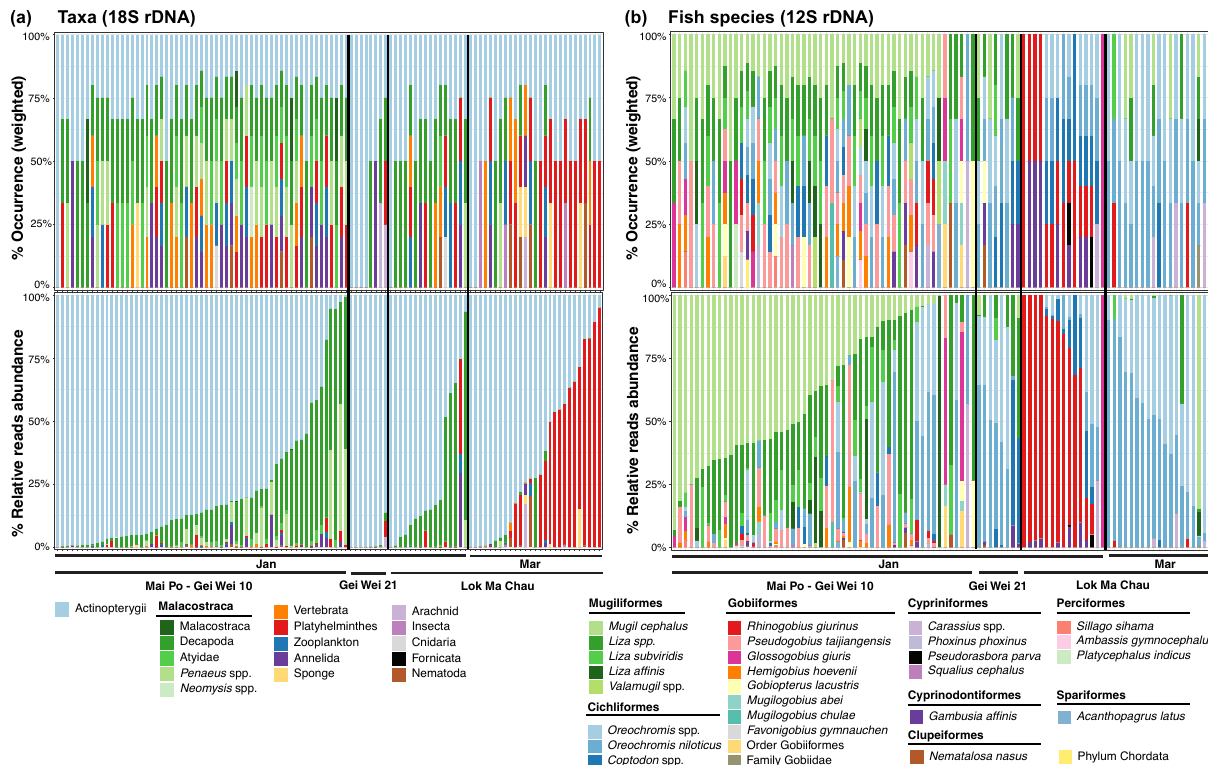
Figure 4. Taxa proportions in the feces of Platalea minor detected using the (a) 18S rDNA (n = 110) and (b) 12S rDNA marker (n = 96). Weighted percentage of occurrence (upper panel) and relative read abundance (lower panel) of each taxon detected in the fecal samples of Platalea minor were shown. Colored bars represent 15 metazoan categories (at genus or higher taxonomic levels) based on 18S rDNA (For taxa categorization, see Supplementary Tables S1 and S3) and 29 fish species detected (at species or higher taxonomic